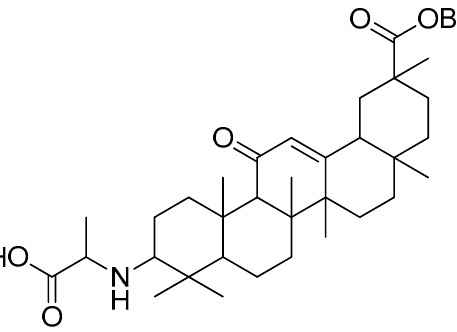
Figure 20. Glycyrrhetinic acid–alanine with amide linkage.